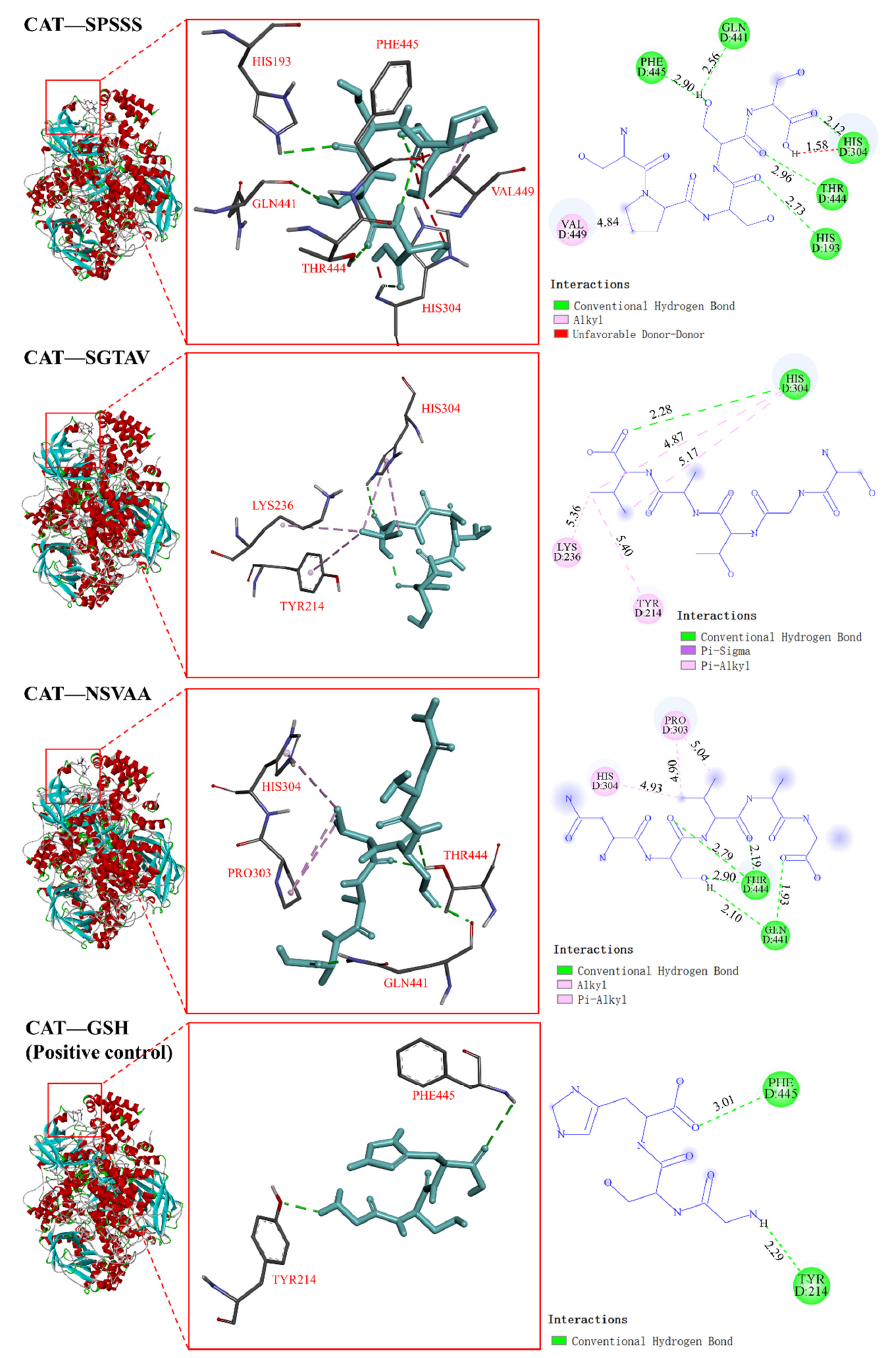
Figure 7. Visualization of molecular docking of antioxidant peptides SPSSS, SGTAV, and NSVAA and positive control (GSH) with CAT.